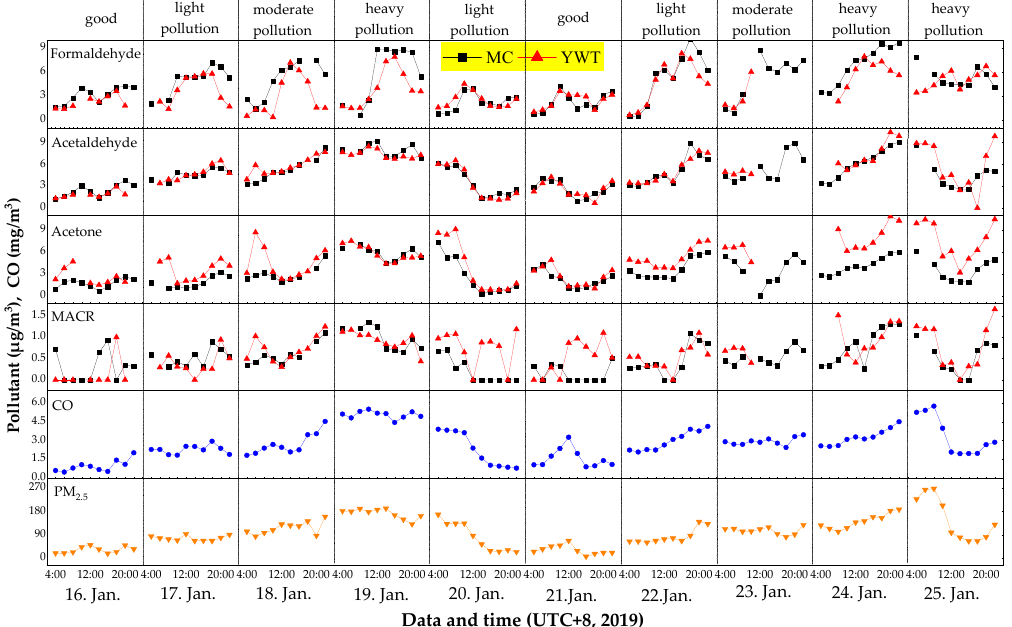
Figure 3. Diurnal variations of formaldehyde, acetaldehyde, acetone, and MACR at MC and YWT and diurnal variations of CO and PM 2.5 at MC from 16 to 25 January 2019.